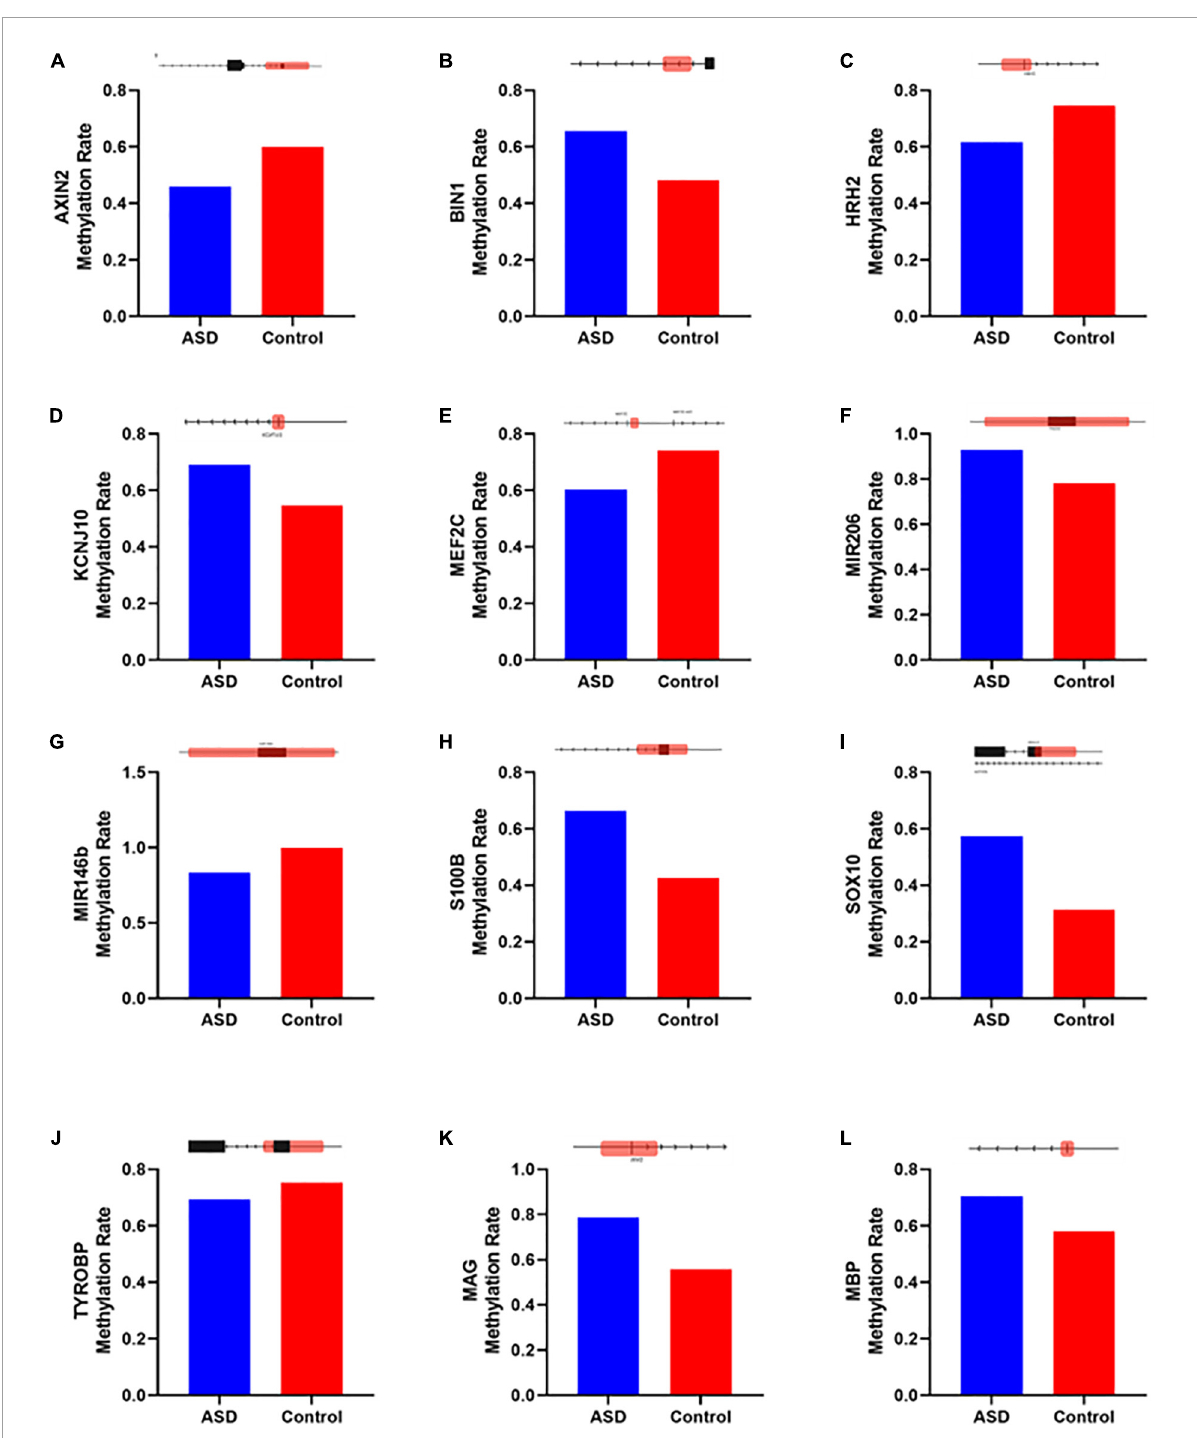
FIGURE7 Genes altered in ASD samples according to IPA that overlap with neurological disease, developmental disorder, and nervous system function and development. Methylation levels were compared between ASD and Control insular cortex samples for genes (A) AXIN2, (B) BIN1, (C) HRH2, (D) KCNJ10, (E) MEF2C, (F) miR-206, (G) miR-146b, (H) S100B, (I) SOX10, (J) TYROBP, (K) MAG, and (L) MBP. Diagrams above each bar graph show a linear depiction of the associated gene from 5 (cid:48) to 3 (cid:48) with the methylation site highlighted in red (1099 bp). Diagrams are not to scale. Reference genome